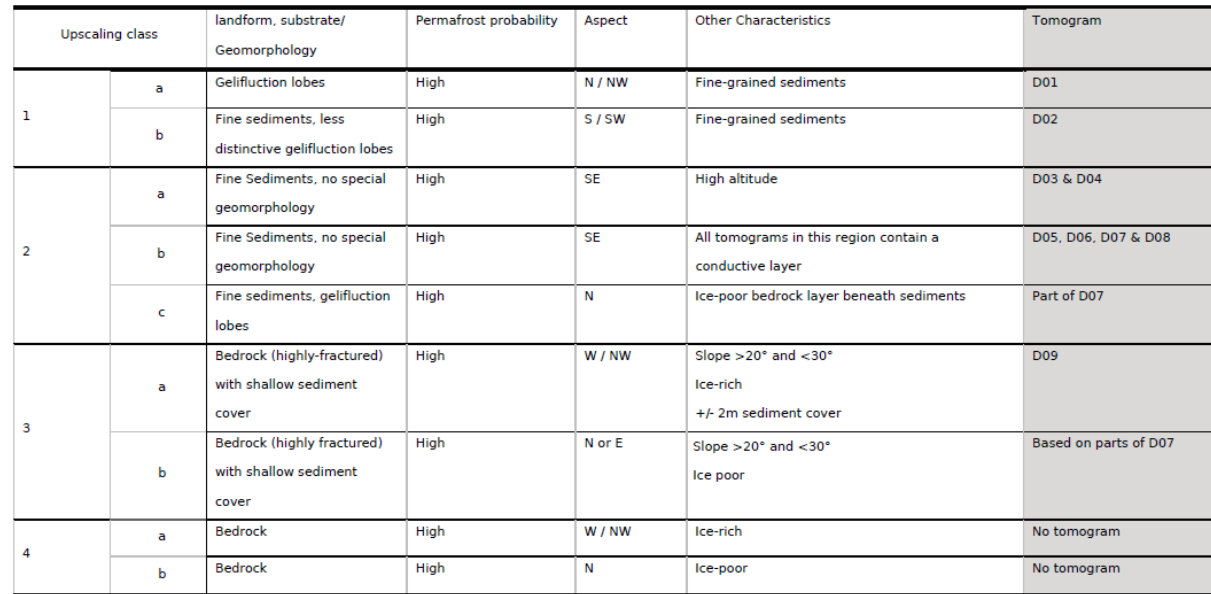
Table 1. Definition of the upscaling classes used for Site